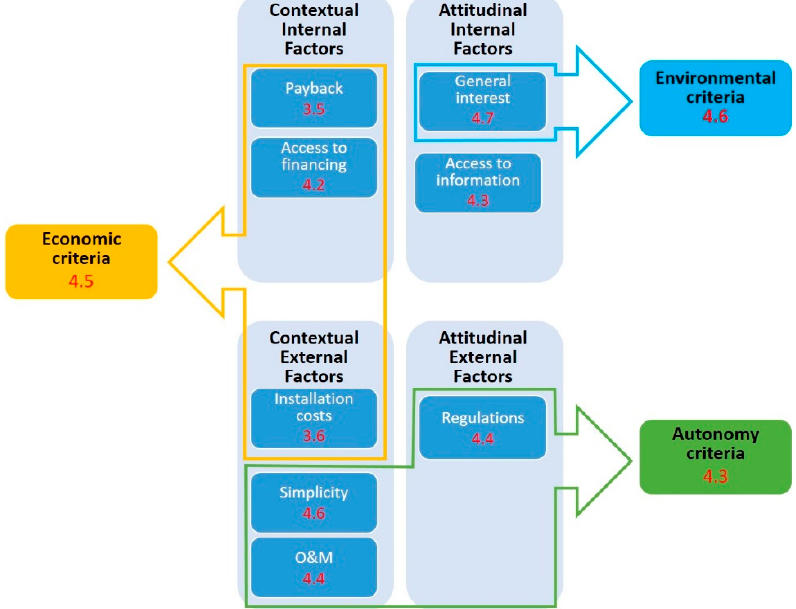
Figure 5. Factors classified using the heuristic approach with respect to the decision criteria. Table 3. Ranking of the relevance of the three factors provided by the prosumers. Case.